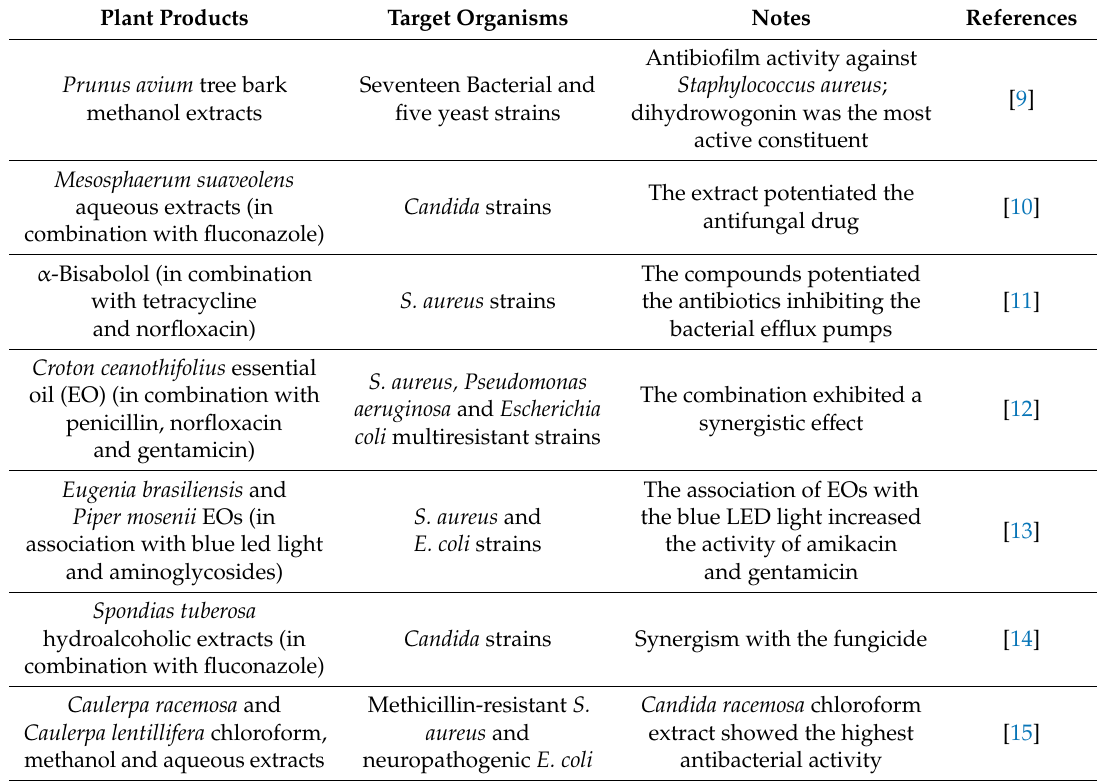
Table 4. Plant products with antimicrobial